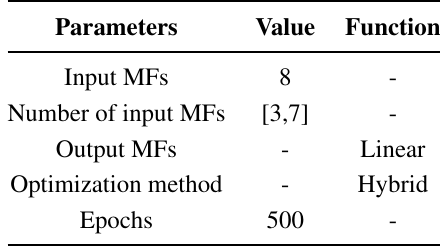
Table 5. ANFIS parameters. MF: member